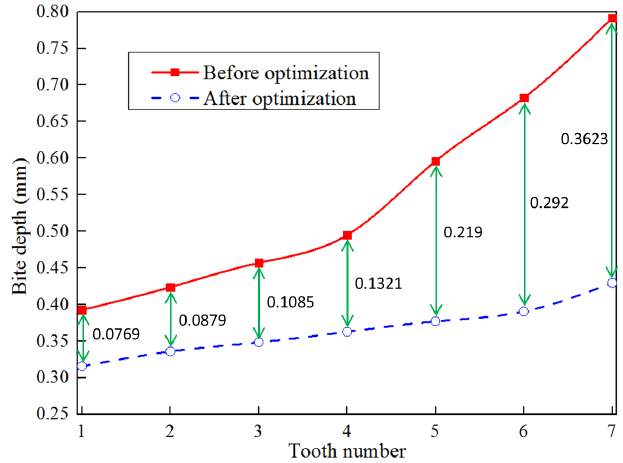
Figure 15. Distribution of bite depth of each tooth.